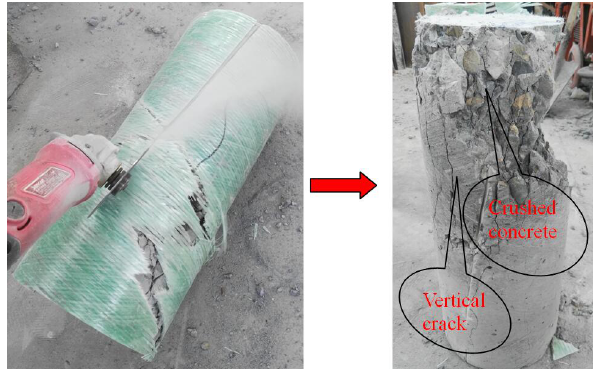
Figure 8: Core nano-silica concrete after the GFRP tube removed